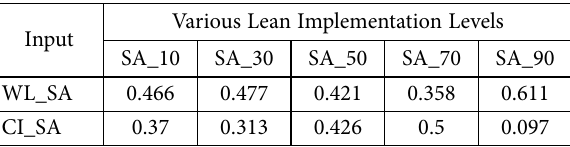
Table 11. Correlation coefficient for inputs and output in level 02 of the model in KSA Input